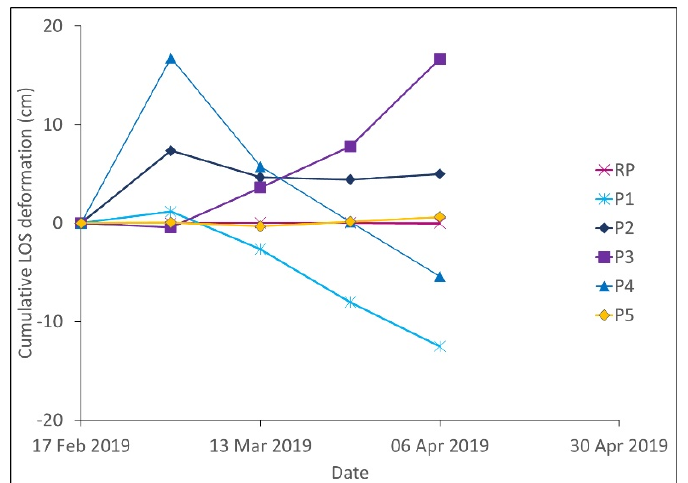
Figure 8. Sentinel-1A (Descending mode) InSAR cumulative LOS deformation (relative deformation between the first date and subsequent dates) from HH polarization (+ for movement toward sensor, − for movement away from sensor).